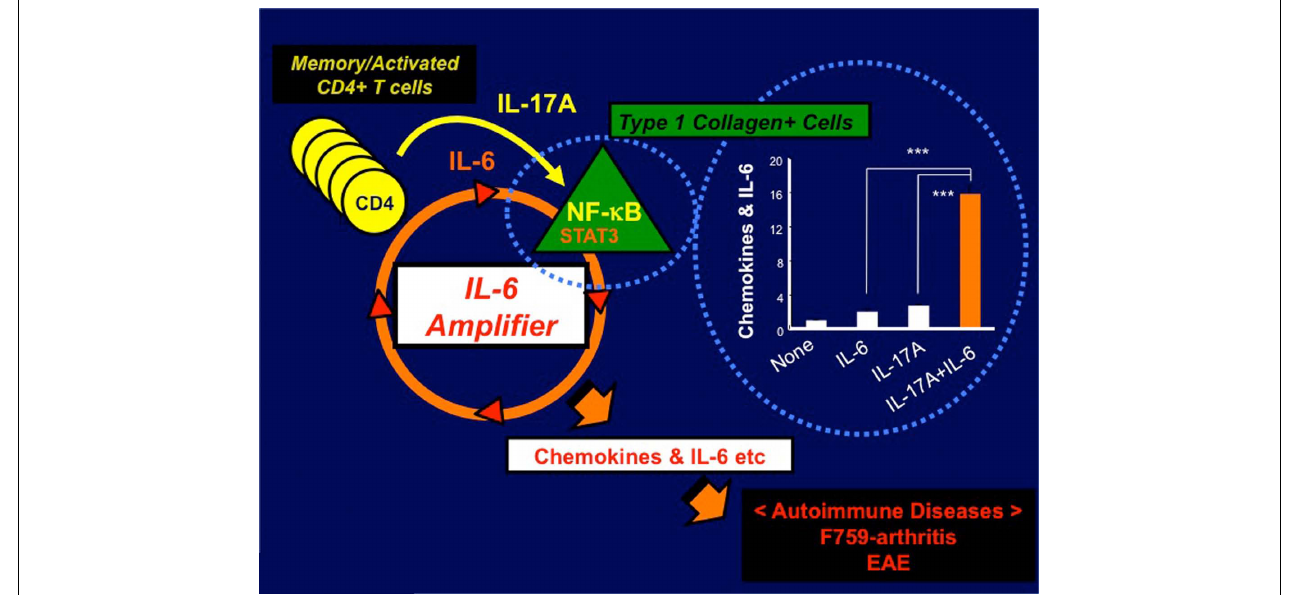
(bar graph).We named this IL-17A-dependent IL-6 signaling amplification loop in type 1 collagen + cells the IL-6-mediated inflammation amplifier , or IL-6 amplifier for short. Importantly, activation of the IL-6 amplifier is critical not only for the development of arthritis in F759 mice but also for MOG antigen-specific,T cell-mediated experimental autoimmune encephalomyelitis (EAE; Ogura et al., 2008).